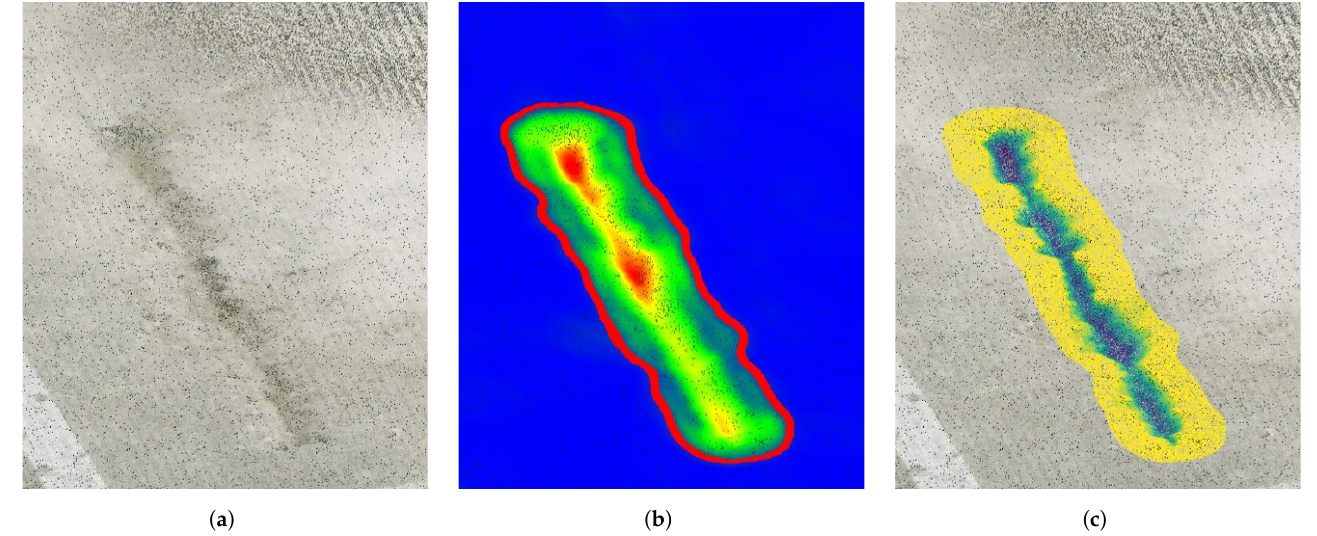
Figure 4. ( a ) point cloud of spalling damage; ( b ) surface variation of point cloud; ( c ) depth of concrete spalling against fitted